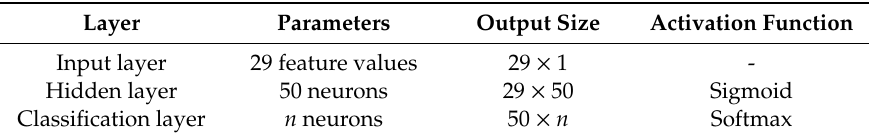
Table 8. Specific setting parameters of the back propagation neural network (BPNN).